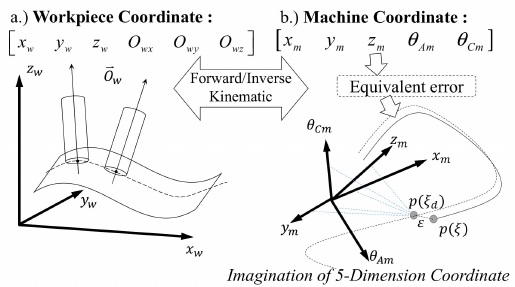
Figure 4. Coordinate transformation and equivalent error: ( a ) workpiece coordinate; ( b ) machine coordinate and equivalent